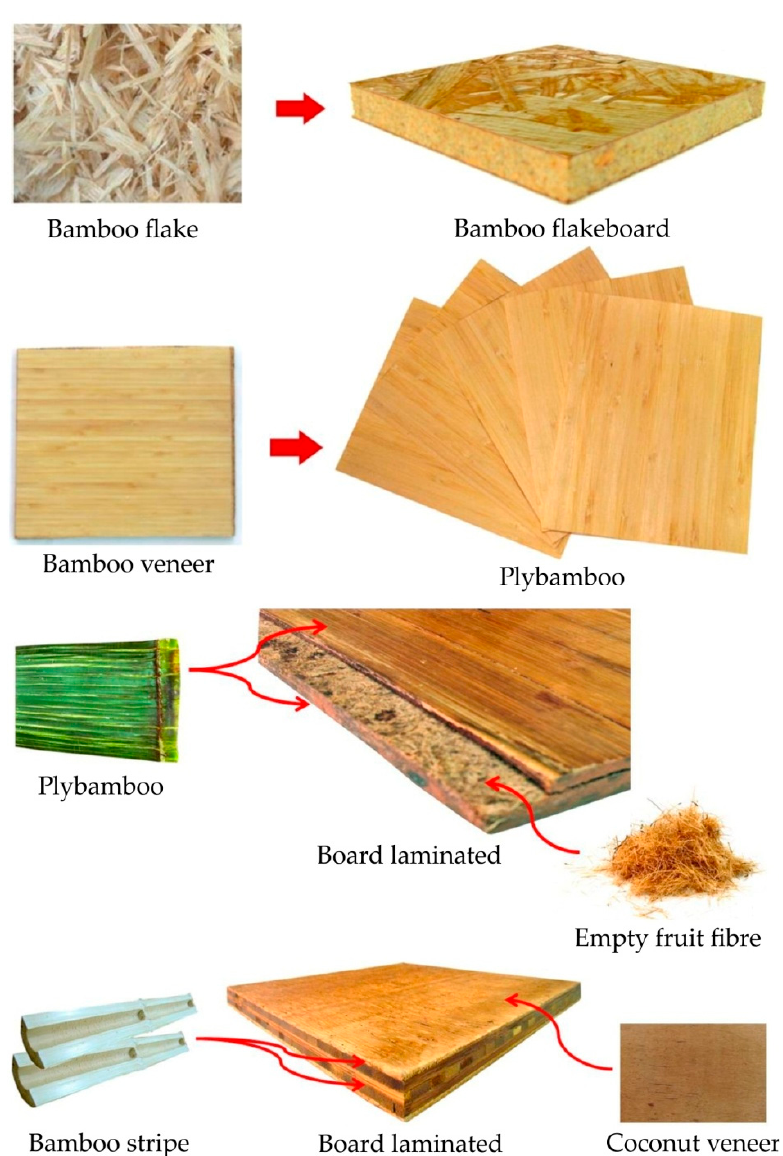
Figure 10. Bamboo boards (reproduced from Ref. [96]; copyright © 2013 The Author(s). Licensee IntechOpen. This material is distributed under the terms of the Creative Commons Attribution 3.0 License, which permits unrestricted use, distribution, and reproduction in any medium, provided the original work is properly cited).